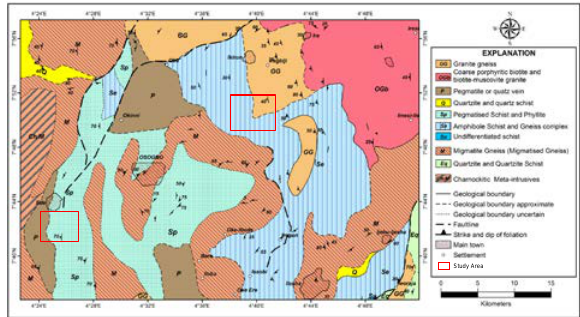
Geological Map of the Study Area (Source; Oyelami and VanRooy,